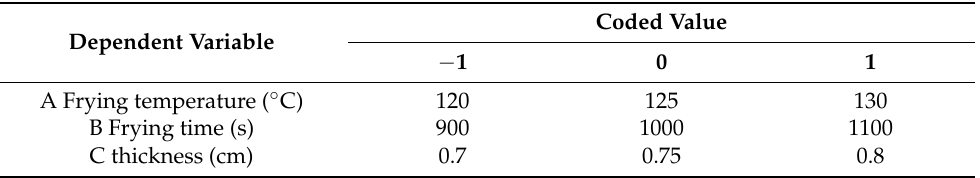
Table 1. Factors and their coded levels used in experimental design for